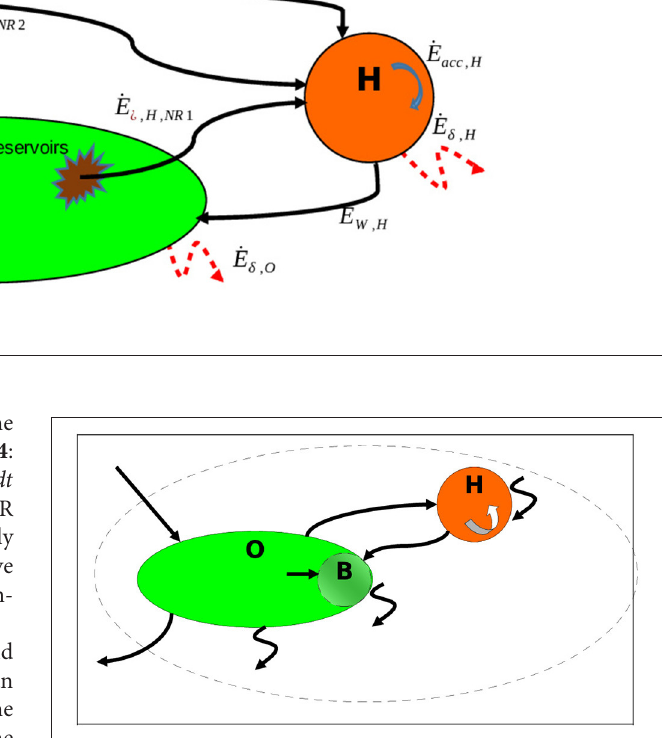
FIGURE 6 | The open-system model with accumulation in H